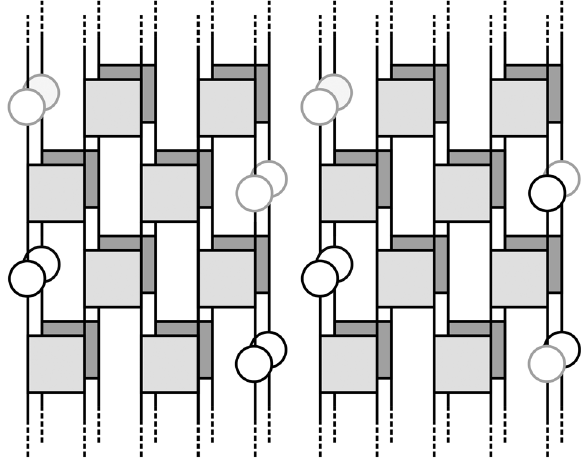
FIG. 27. Configuration of single-site Haar-random matrices u ð r Þ L;R , drawn as open circles, used to impose the local diagonal pairings at the ends of the system, which define Z ð s; t Þ [see Eq. (38)], here for t ¼ 2 . Gray and black circles represent independent matrices, and furthermore, the matrices at the left- hand sites and the right-hand sites are independent. Other conventions are as in Fig. 6. Averaging over the single-site matrices in the left-hand diagram fixes s L ¼ 0 and s R ¼ 0 , so we find Z ð 0 ; 2 Þ . In the right-hand diagram, this average fixes s L ¼ 0 and s R ¼ 1 , so we find Z ð 1 ; 2 Þ .